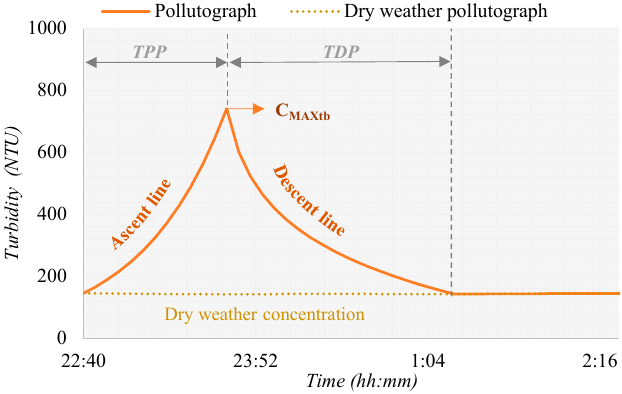
Figure 8. Main parameters of a design pollutograph.